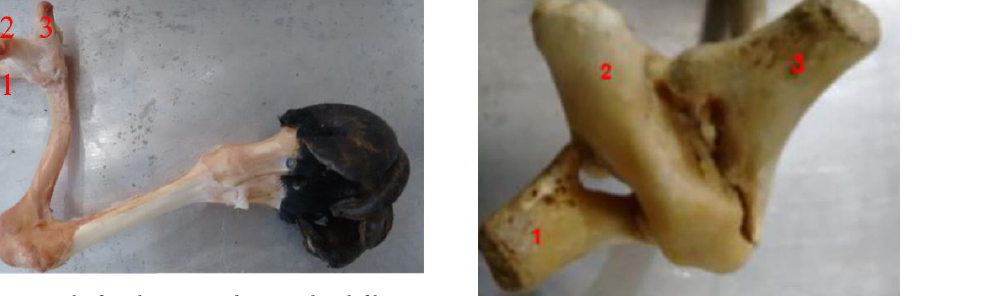
Figure 8. Bones of the accessory limb: (1) olecranon; (2) humerus; and (3) head of the radius.